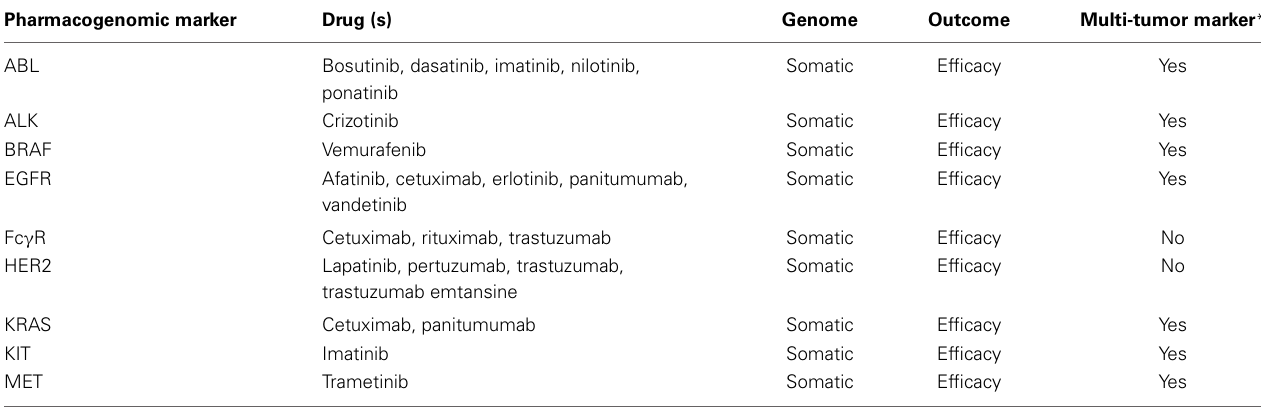
Table 1 | Selected somatic pharmacogenomic markers.